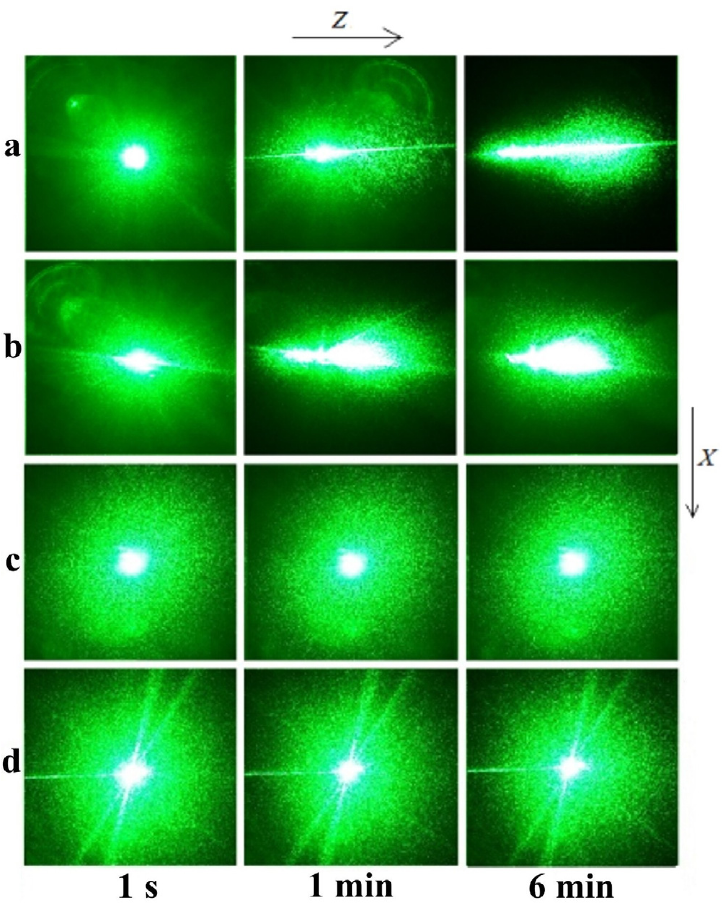
Figure 4. PILS patterns of ( a ) CLN, ( b ) NSLN K 2 O, ( c ) sample 1, ( d ) sample 2. I = 6.29 W/cm 2.